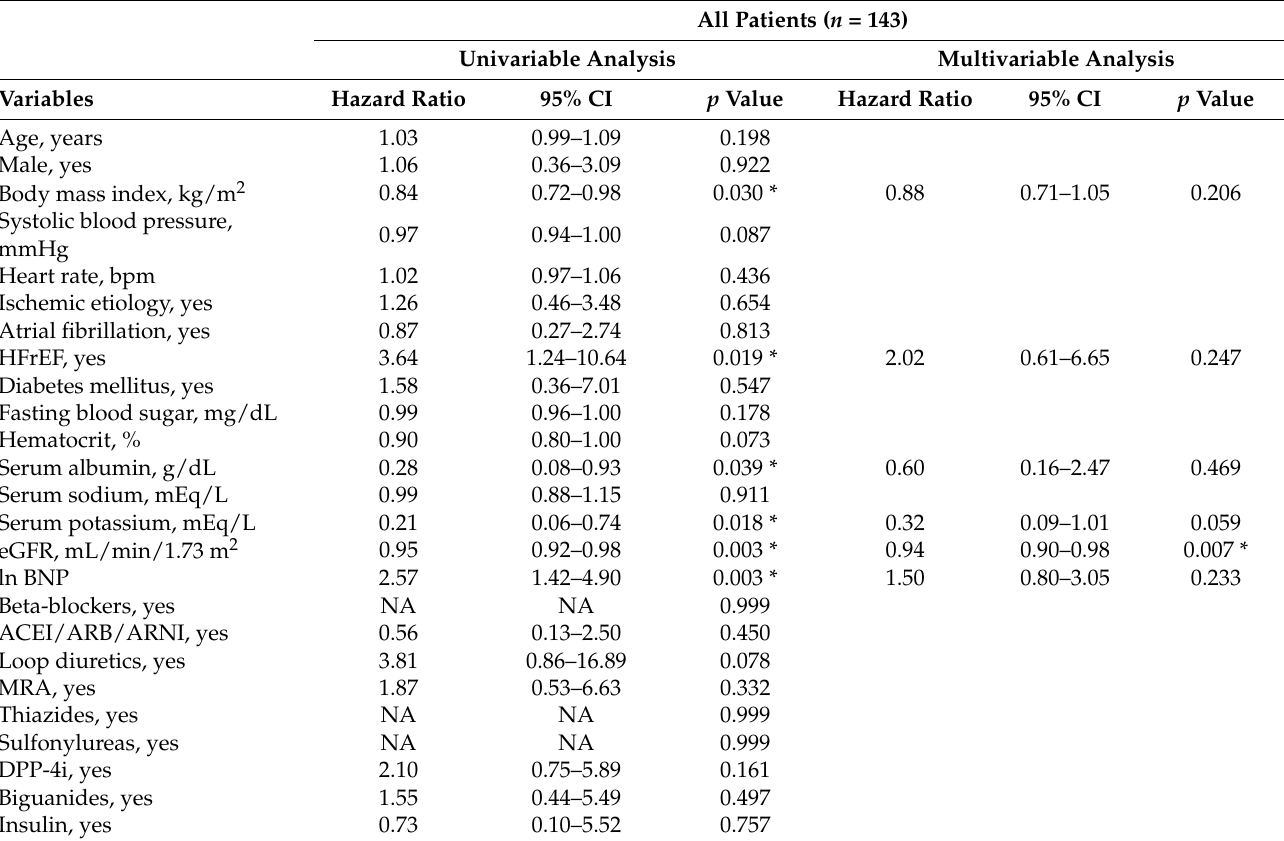
Table 2. Variables associated with recurrent hospitalization for heart